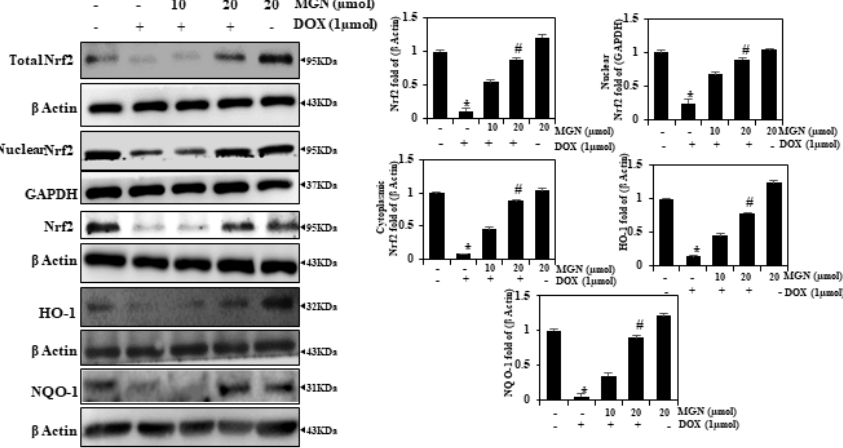
Figure 5. MGN upregulates the antioxidant biomarkers Nrf2, NQO1, and HO-1 in DOX-induced endothelial cells. MGN (10 or 20 µ M for 24 h) and/or DOX were used for the pretreatment of cells. Western blot findings showed the effects of MGN on Nrf2, NQO-1, and HO-1 on cytoplasmic, nuclear, and total protein concentrations in whole cells. For each sample, 50 µ g of lysate were resolved in total, with β -actin used as an internal control protein. Densitometry was conducted to calculate relative shifts in protein band intensities. The outcome was measured and expressed as a fold change compared to the control ( n = 3). Data are represented as mean ± SEM. One-way ANOVA plus Tukey’s post hoc analysis analyzed the comparison between groups. * p < 0.05 reflects significant differences from the healthy control. # p < 0.05 reflects significant differences in contrast to DOX alone and MGN with DOX-treated groups.